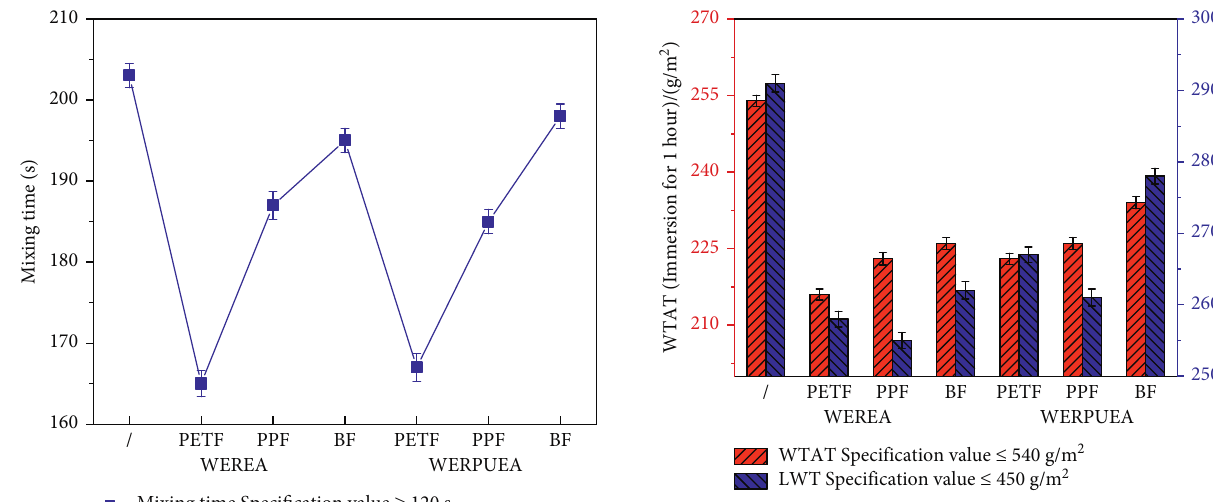
Figure 7: WTAT and LWT of different types of microsurfacing. Figure 8: The pull-off strength and PLD of the